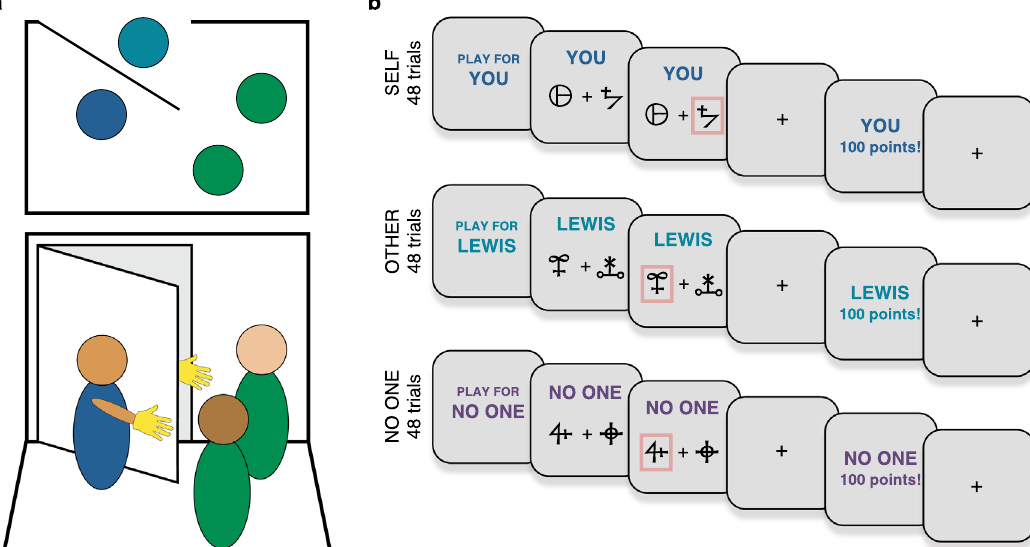
Fig. 1 Prosocial learning task and social role assignment. a The role-assignment procedure involved the participant (dark blue), confederate (light blue) and two experimenters (green). Top: from above showing the positioning of the participant and two experimenters inside the testing room, and the confederate on the other side of the door. Bottom: the participant and confederate wore a glove to disguise their identity and waved to each other from either side of the door. Participants were instructed that they would be assigned to roles of ‘ Player 1 ’ and ‘ Player 2 ’ , but the participant was always assigned to be Player 1. After this procedure, participants were informed that they would play a game where they could gain rewards for themselves, the other participant (Player 2) or neither participant. They were told that Player 2 would not play the same game for them, and that Player 2 would not know that they may receive an additional bonus based on the choices the participant made. This meant that participants ’ choices were made anonymously and should not be affected by reputational concerns. b Participants performed a reinforcement-learning task ( ‘ prosocial learning task ’ ), in which they had to learn the probability that abstract symbols were rewarded to gain points. At the beginning of each block, participants were told who they were playing for, either themselves, for the other participant, or in a condition where no one received the outcome. Points from the ‘ self ’ condition were converted into additional payment for the participant themselves, points from the ‘ other ’ condition were converted into money for Player 2, and points from the ‘ no one ’ condition were displayed but not converted into any money for